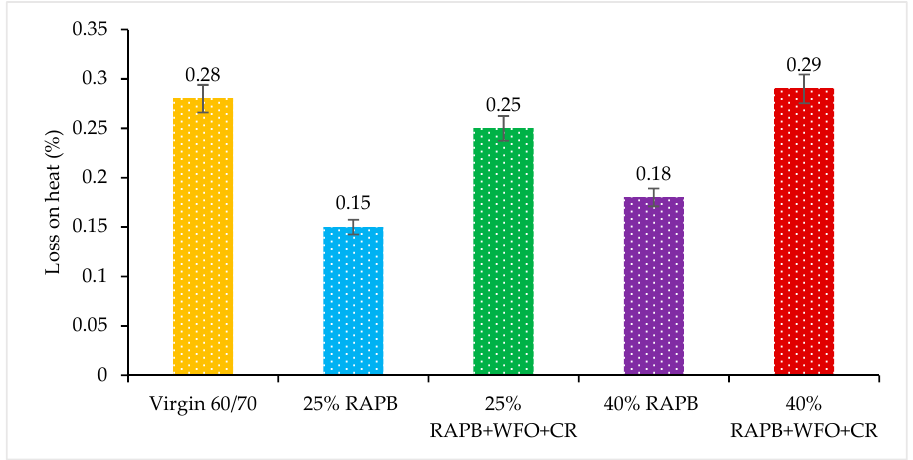
Figure 9. Loss of heating results for all binders.